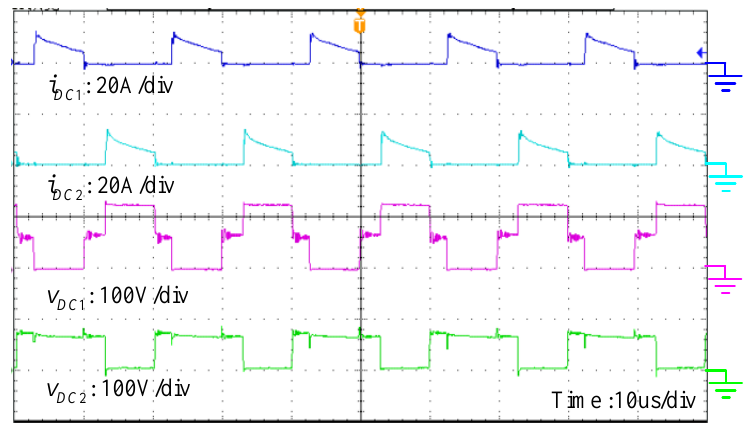
Figure 13. Measured waveforms of the voltages and currents on the clamp diodes.